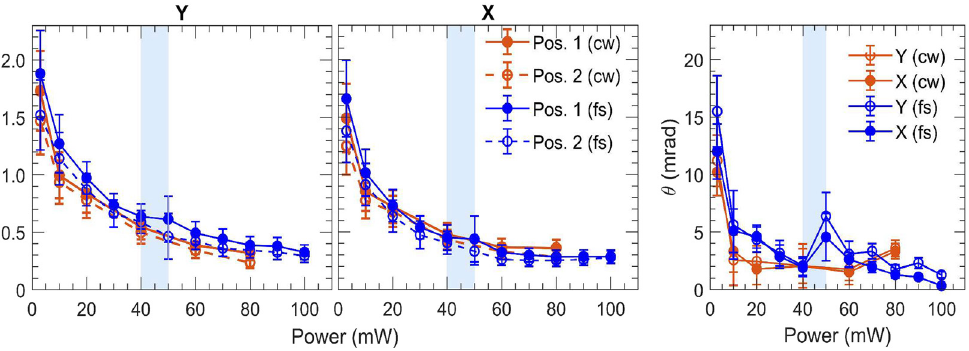
Figure 5: Comparison between use of cw and fs excitation on the experimental measurements of the far-field FWHM beam width and divergence θ for sample S1, as a function of power for d =